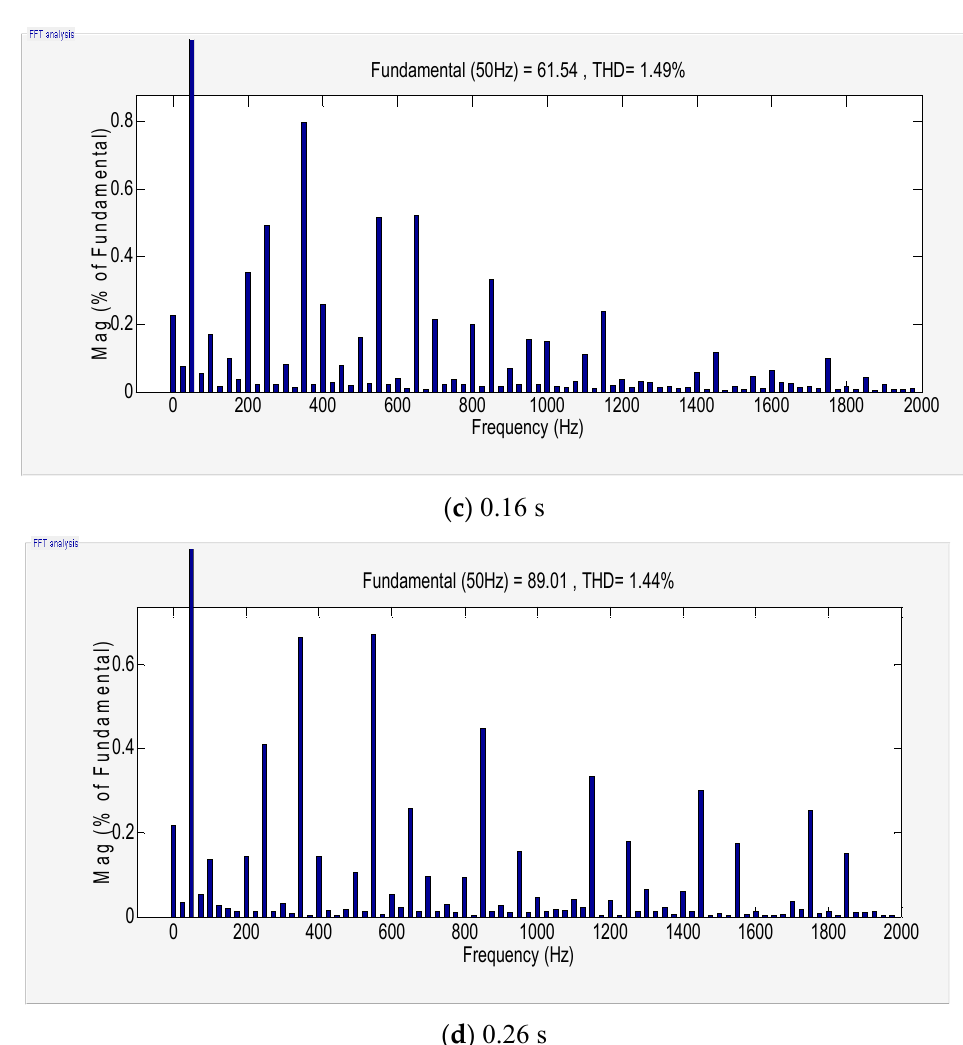
Figure 13. Harmonic spectrum of the fuzzy sliding mode control at di ff erent times. Table 2. THD in the proposed controller and a normal controller.